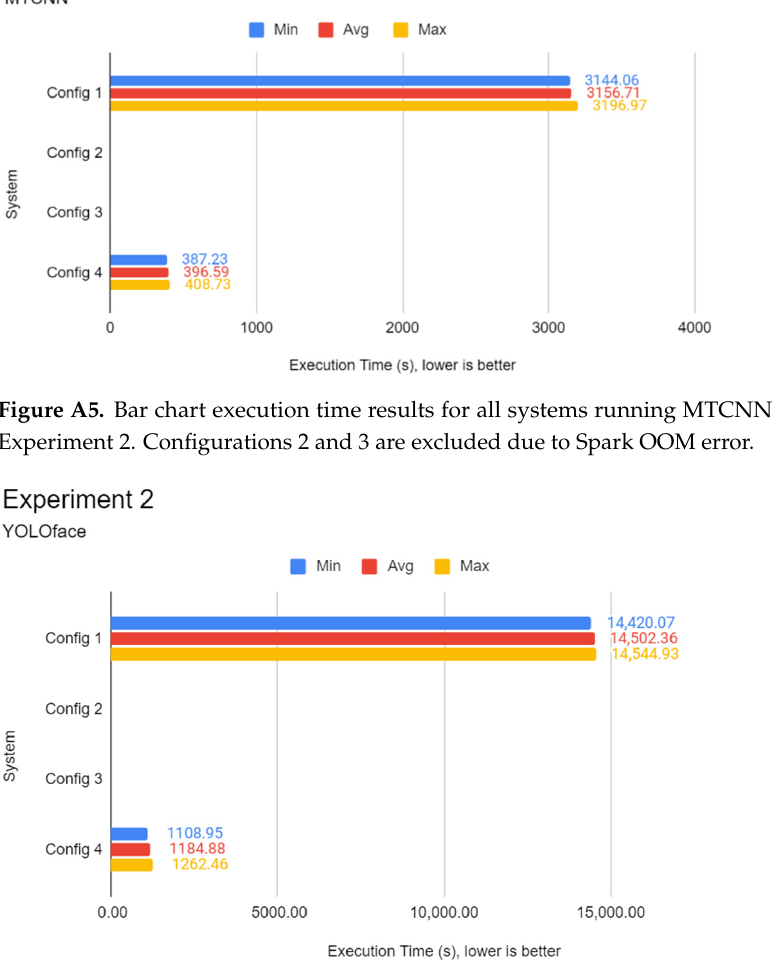
Figure A6. Bar chart execution time results for all systems running YOLOface on WIDER FACE in Experiment 2. Configurations 2 and 3 are excluded due to Spark OOM error.